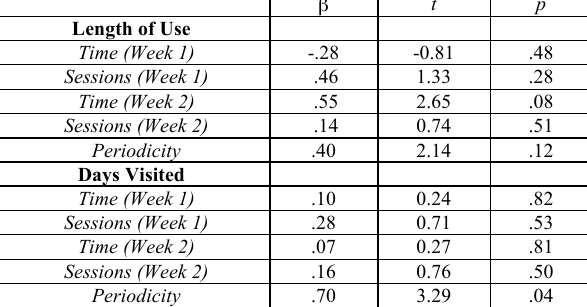
TABLE I. USAGE VARIABLES PREDICTING